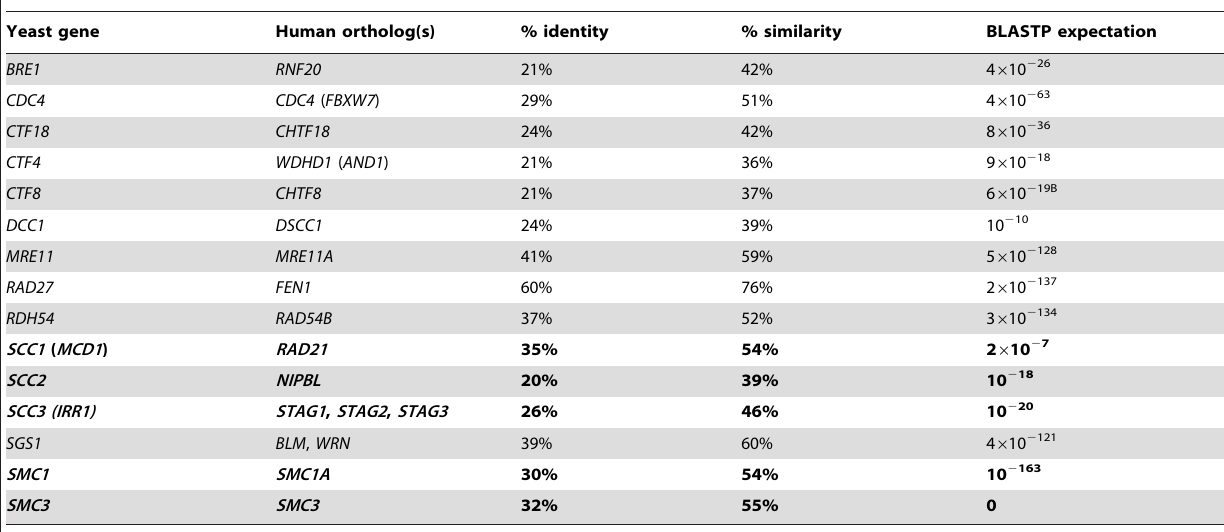
A Names indicated are the names used in this work. Names in parentheses indicate common alternative gene names. Members of the cohesin complex (and SCC2/NIPBL , a cohesin loader) are indicated in boldface